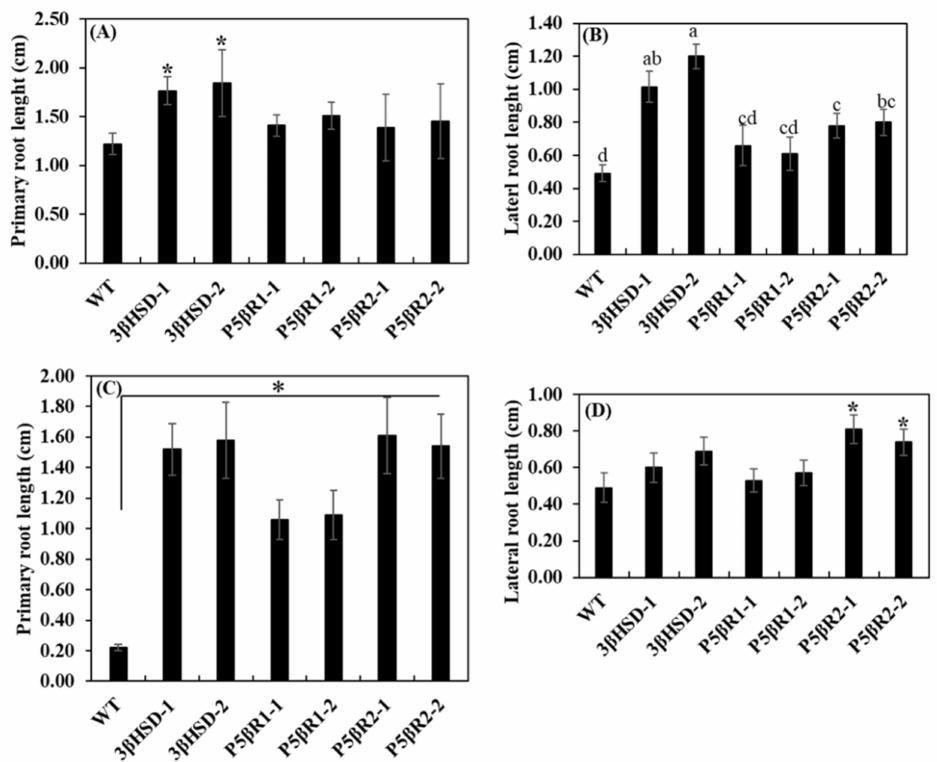
Figure 4. Primary and lateral root lengths of WT and transplastomic lines of the 3 β -HSD , P5 β R1 and P5 β R2 genes under control (0 mM NaCl) and 300 mM of NaCl stress on MS agar media over one month. ( A ) Primary root lengths of WT and two independent transgenic lines each of the 3 β -HSD , P5 β R1 , and P5 β R2 genes under the control treatment; ( B ) lateral root lengths of the seedlings under the control treatment; ( C ) primary root lengths of the seedlings under 300 mM NaCl stress; ( D ) lateral root lengths of salt-stressed (300 mM NaCl) seedlings. Asterisks or different letters show significant differences at p < 0.05 (WT, n = 3, transplastomic lines, n = 8 for each repeat of each line) among the WT and the lines in each figure. Data shows average of three repeats and error bars represent ±